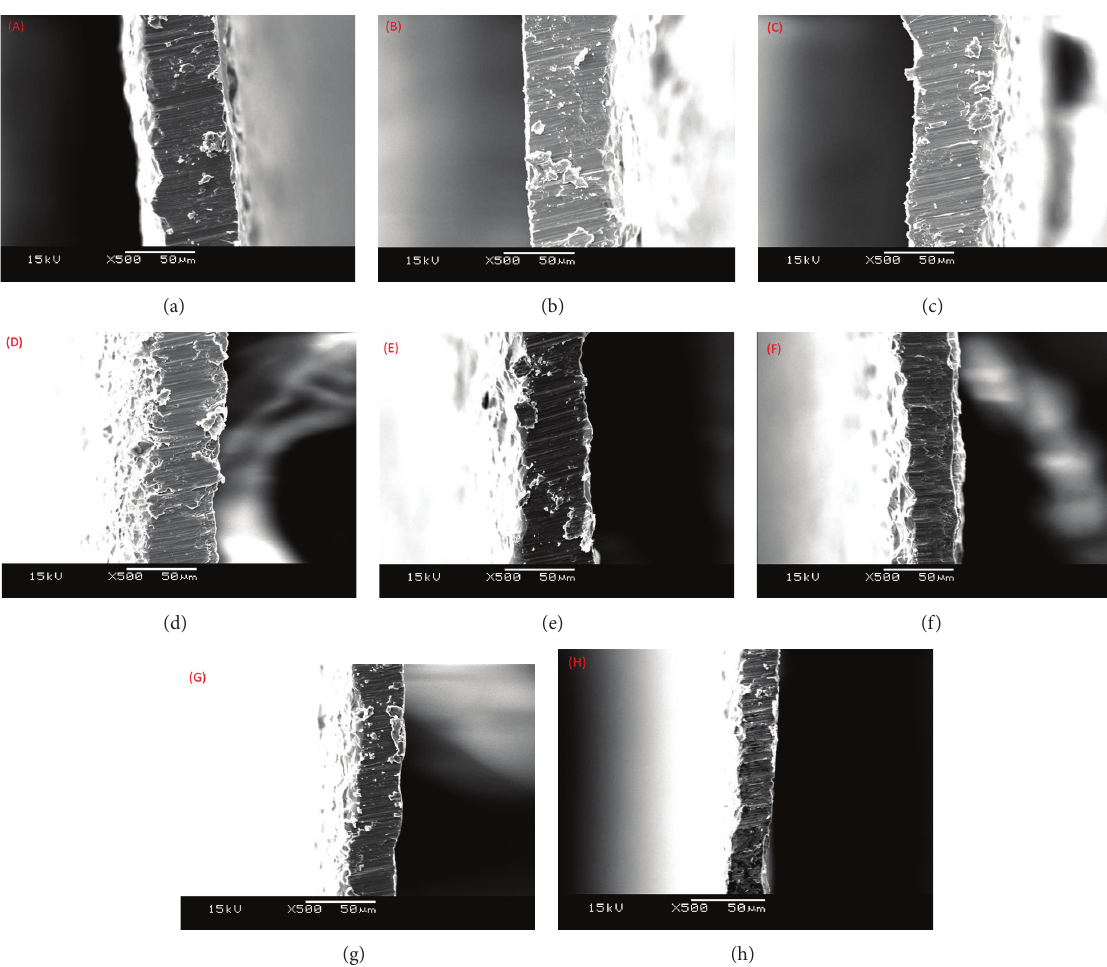
Figure 4: Cross-section morphologies of electrochemical polishing-chemical etching under different times (a) 10min, (b) 11min, (c) 12min, (d) 13min, (e) 14min, (f) 15min, (g) 16min, and (h) 17min. out at room temperature. After the electrochemical process, the foils were annealed at 450 ∘ C for 3